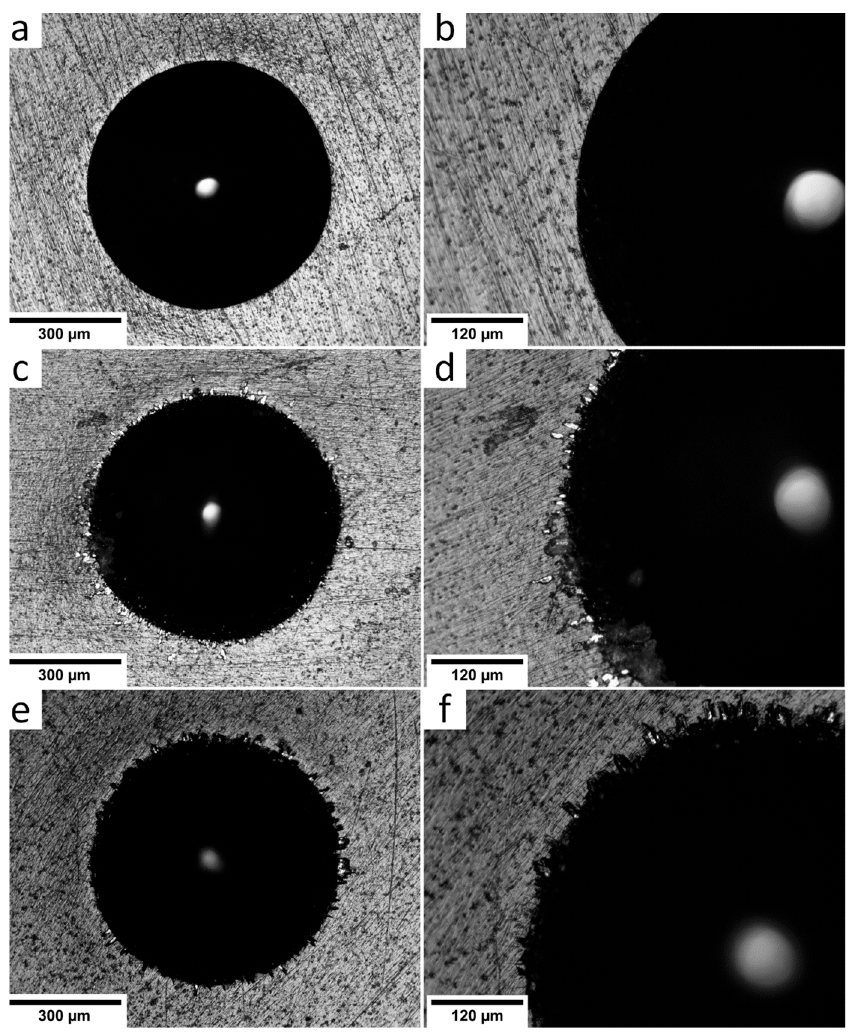
Figure 5. Optical micrographs of Ti-6Al-4V surface with deposited a-C:H:SiO x films of different thickness after the Rockwell indentation process: ( a , b ) 0.5 µm, ( c , d ) 1.5 µm, ( e , f ) 3 µm.